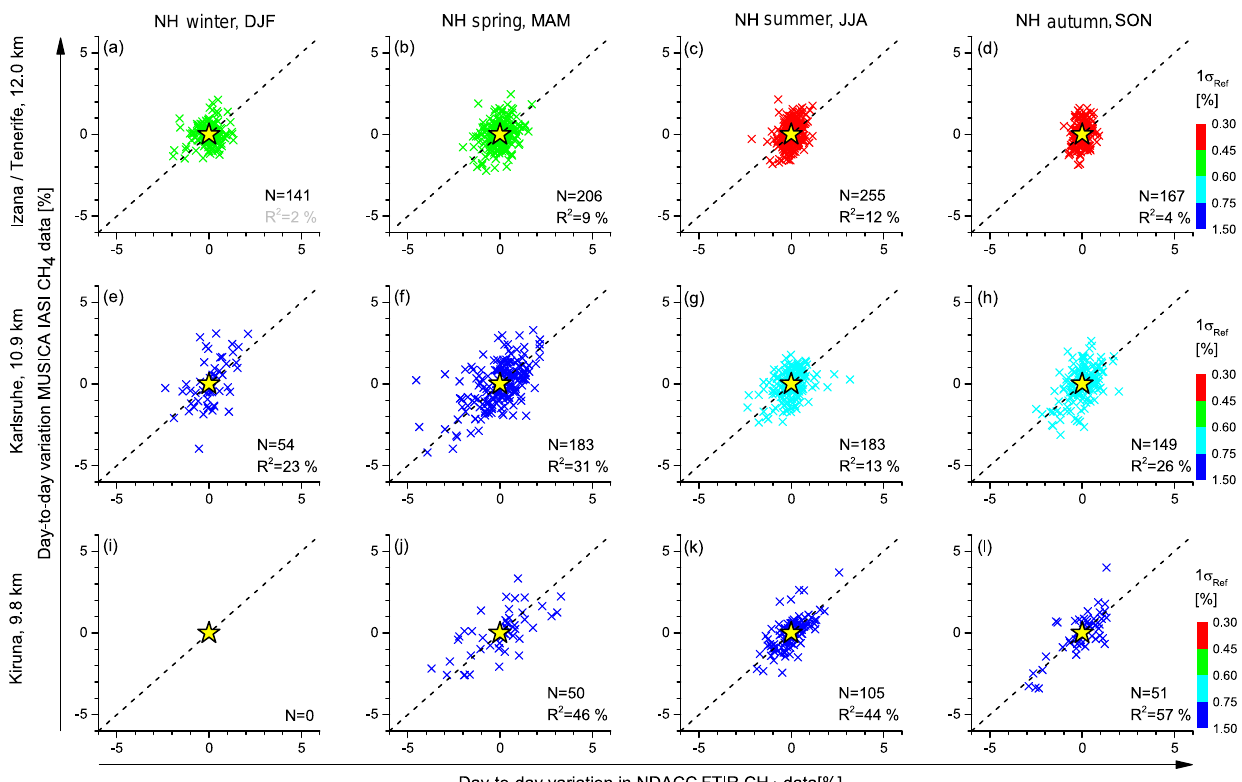
Figure 22. Same as Fig. 21, but for correlations of CH 4 and at altitudes representing the UTLS regions. R 2 values in black indicate significant positive correlations (95% confidence level) and grey indicate no significance.